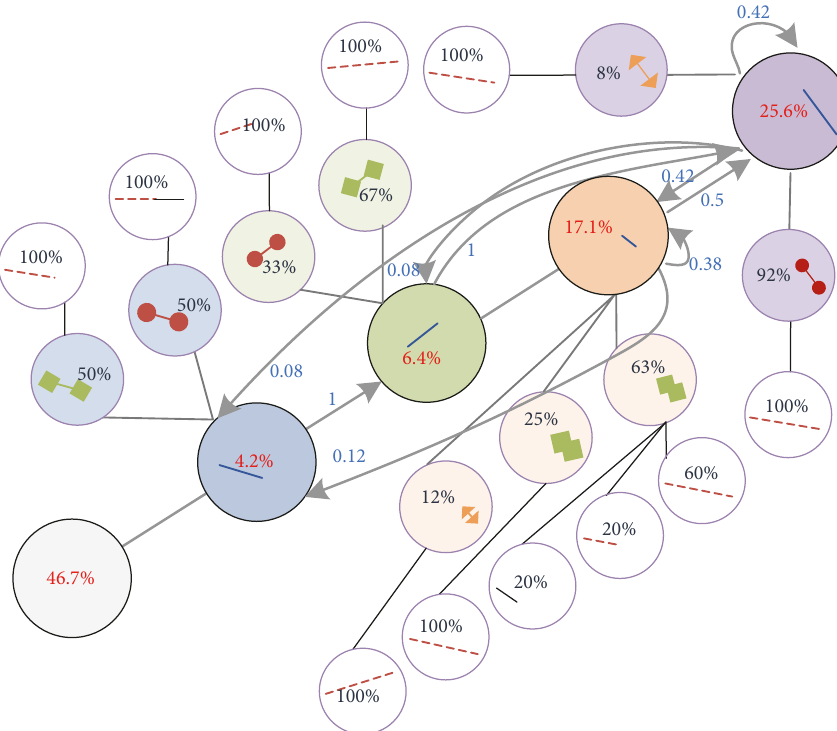
Figure 9: Individual travel behavior graph of passenger P2.